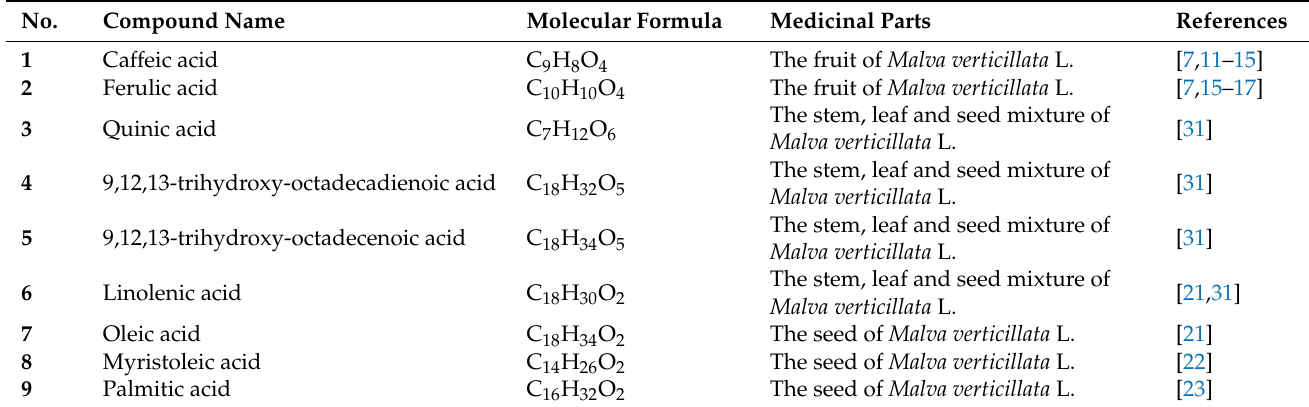
Table 1. The acid compounds identified from Fructus Malvae .